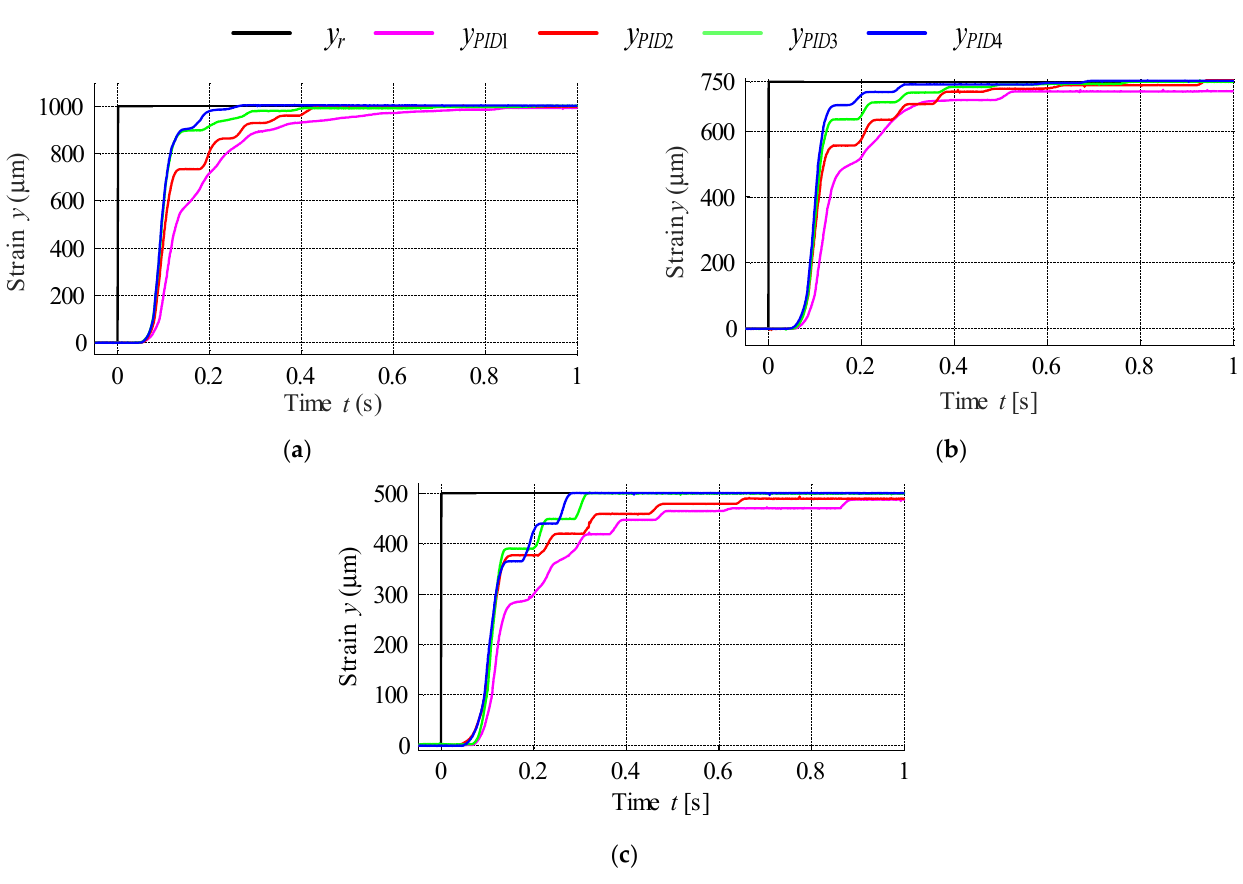
Figure 24. Actuator step response for position references: ( a ) 1000 µm, ( b ) 750 µm and ( c ) 500 µm. Table 6. Rise time.